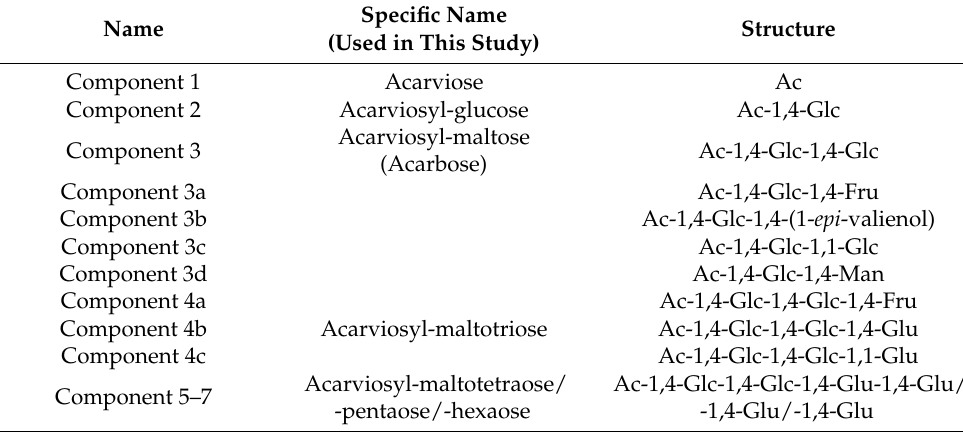
Figure 1. Structural formula of acarbose. Acarbose consists of an acarviosyl moiety and a maltose residue. Table 1. Structure of acarbose and related acarviosyl metabolites (Ac = acarviose, Glc = glucose, Fru = fructose, Man = mannose). Structures of components 3–4c according to Wehmeier and Piepers- berg